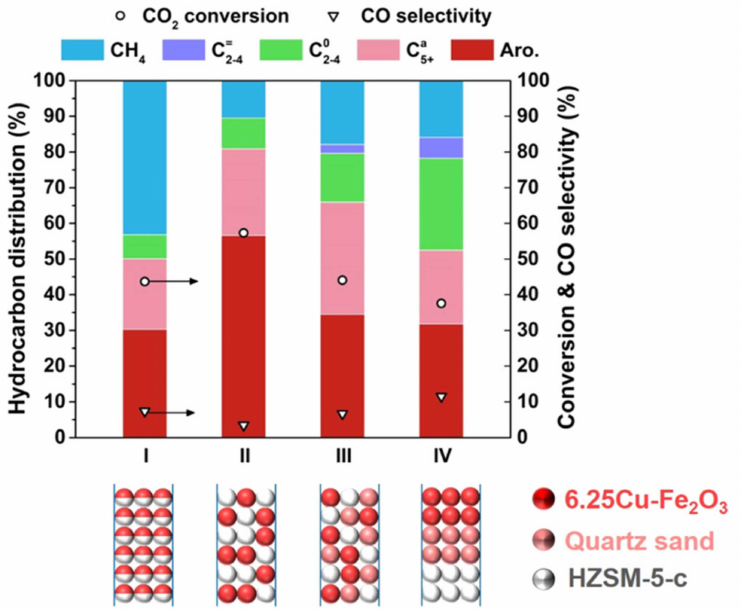
Figure 18. Effects of different mixing modes of 6.25Cu-Fe 2 O 3 /HZSM-5-c tandem catalysts on catalytic performance. I: Powder-mixing, II: Granule-mixing, III: Granule-mixing with quartz sand, IV: